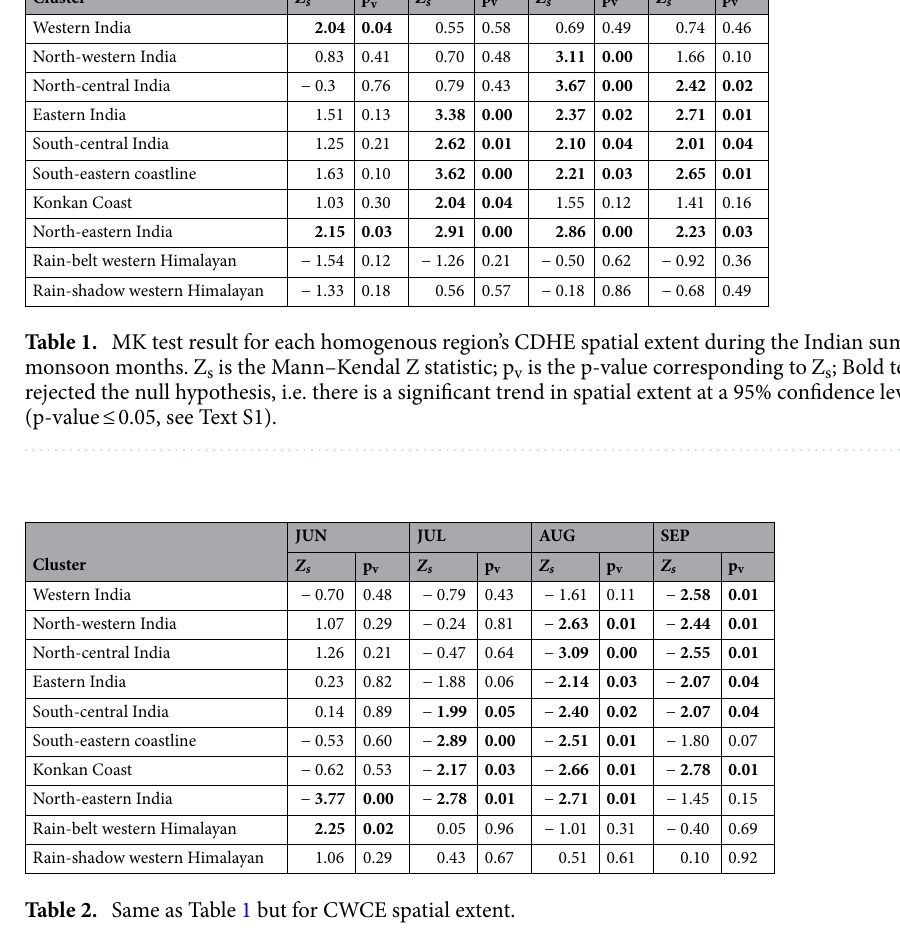
are given in Tables 1 and 2, respectively.